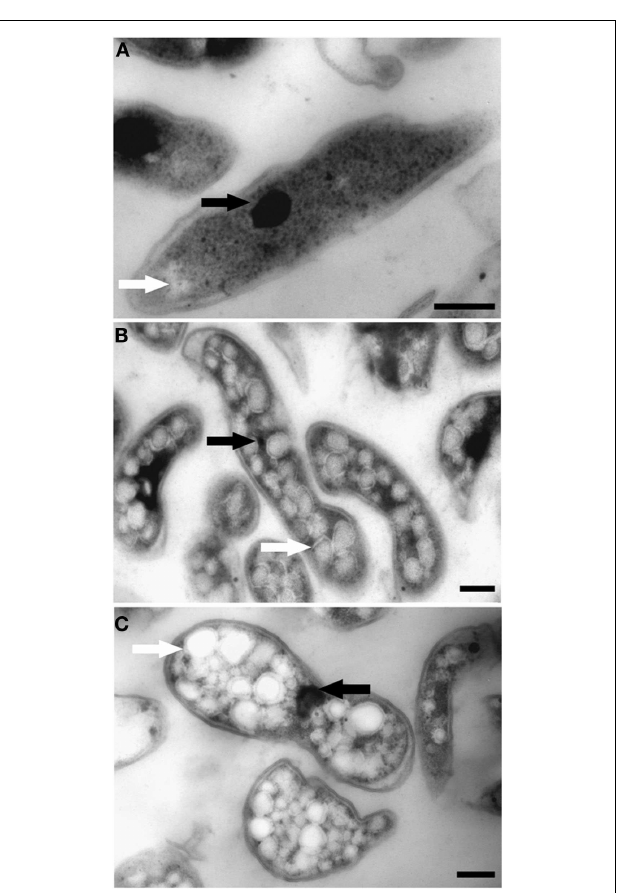
FIGURE 5 |Transmission electron micrographs showing chemically fixed, Epon-embedded thin sections of “ Ca. M. fumariolicum” cells in different growth phases. (A) Cell from the exponential phase. (B) Cells taken at the end of transition phase I. (C) Cells taken at the end of transition phase II. Electron light (white arrows) particles are seen in all growth phases, but are especially abundant in cells of transition phase I and II. Electron dense particles (black arrows) are present in all growth phases. Scale bars,